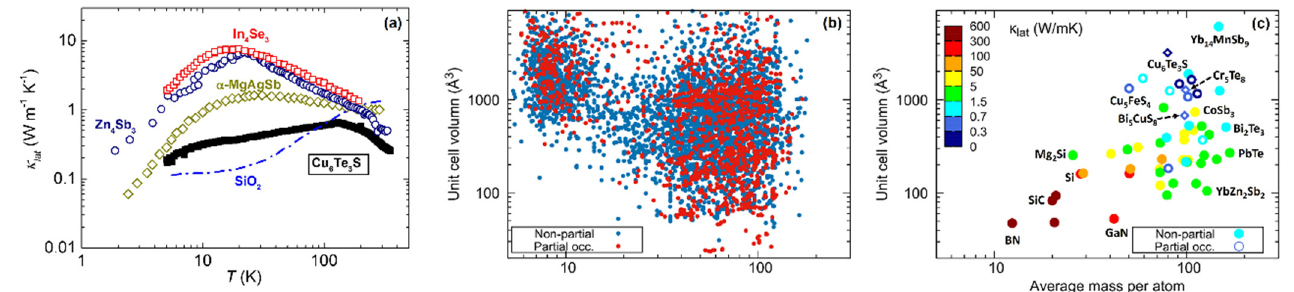
Figure 4. ( a ) Glass-like thermal conductivity of Cu 6 Te 3 S with partial occupancy ( b ) obtained data- base of compounds with partial occupancy ( c ) low thermal conductivity compounds newly un- earthed and verified utilizing partial occupancy as a descriptor